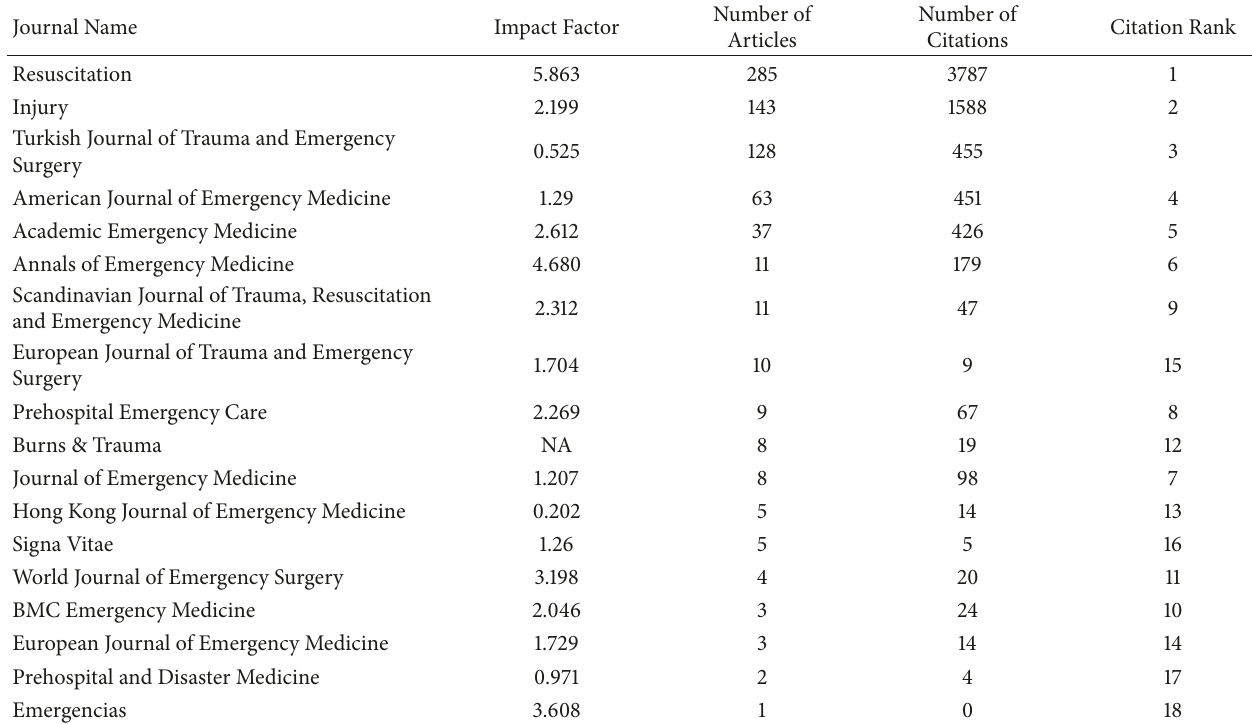
Table 1: Distribution of the number of articles and their citation status according to the journals.